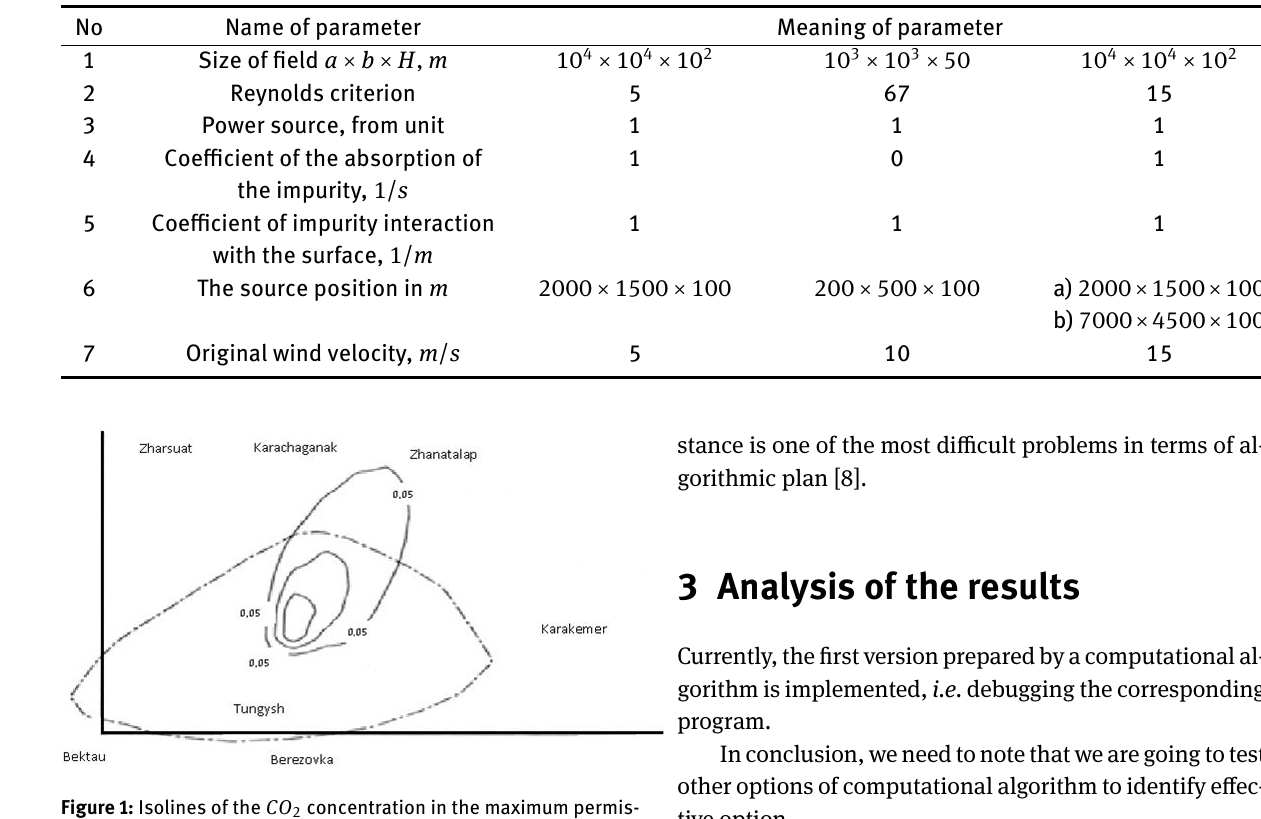
Figure 1: Isolines of the CO 2 concentration in the maximum permis- sible concentration shares at a height of 650 m . Max CO 2 − 0, 22 .